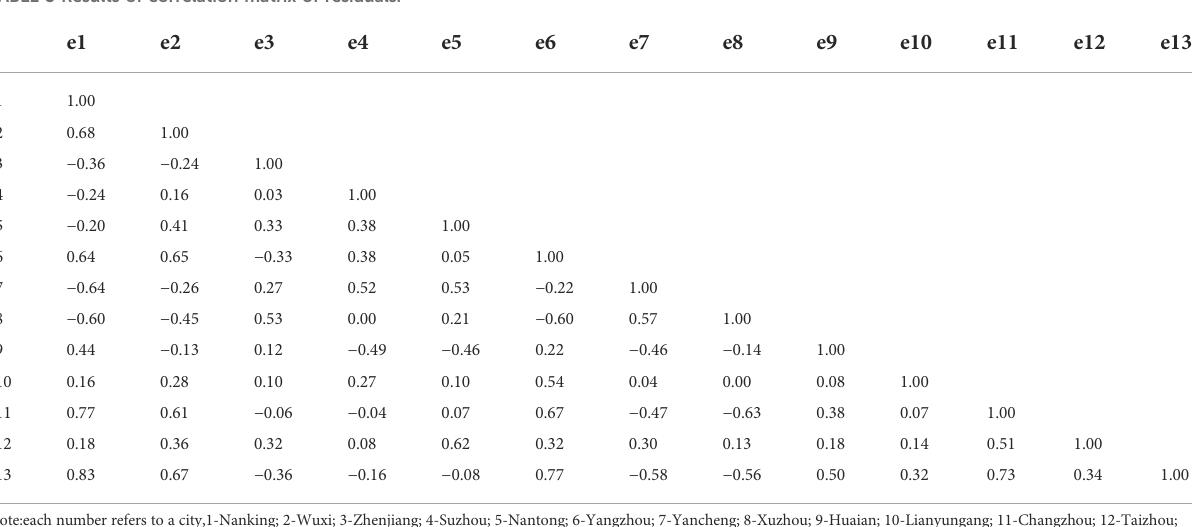
TABLE 5 Results of correlation matrix of residuals.